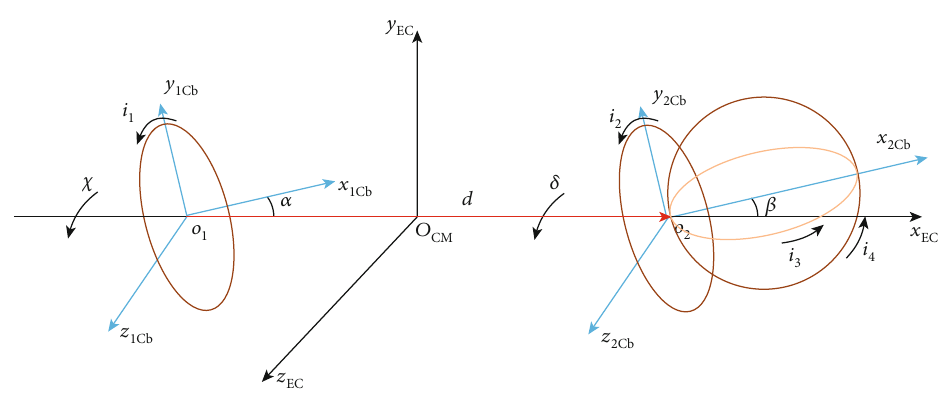
Figure 11: Con fi gurations of the coils on Sat1 and Sat2 in the EC